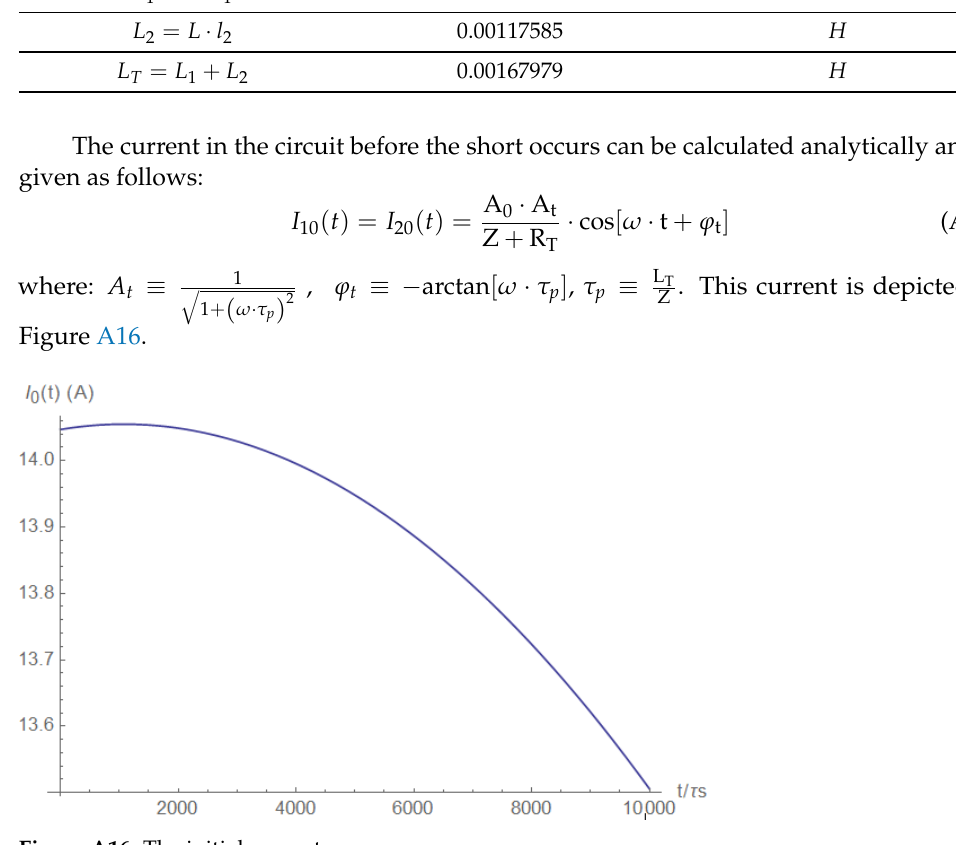
Figure A16. The initial current.